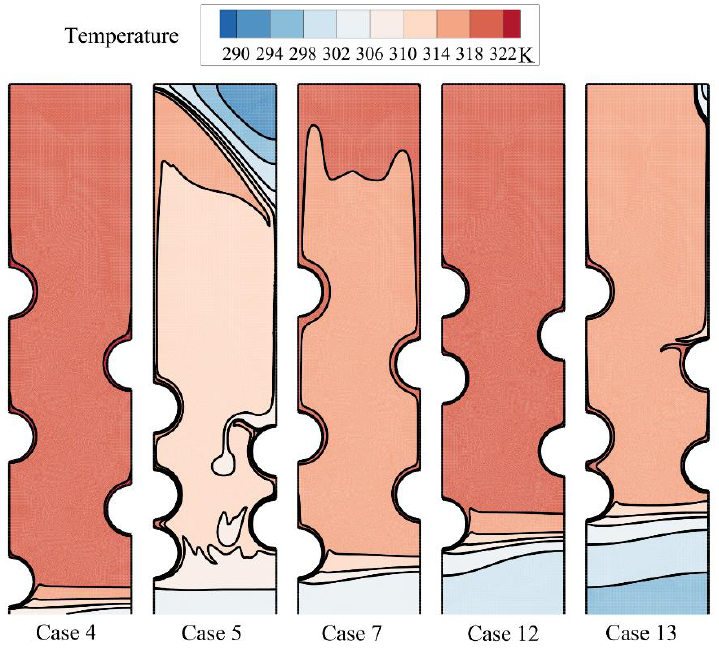
Figure 13. The isotherms for five different tubes ’ arrangement after four hours of charging.